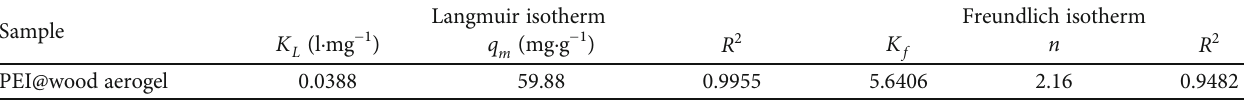
Table 3: Langmuir and Freundlich isotherm parameters for the adsorption of Cu(II) by PEI@wood aerogel. Sample